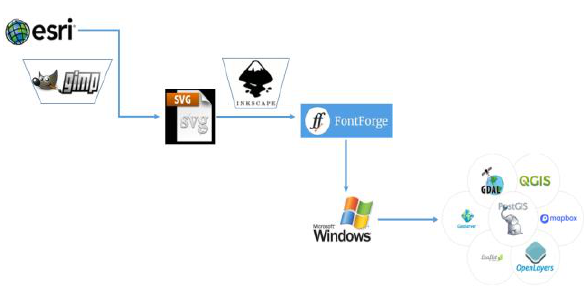
Figure 5 . Workflow diagram.